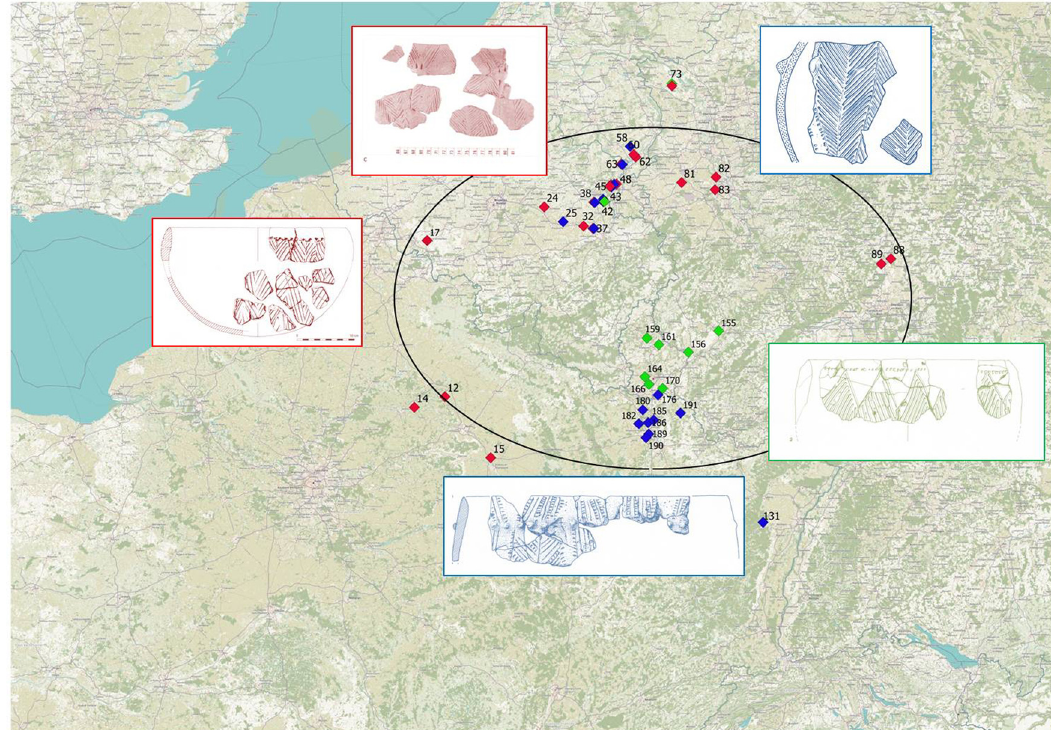
Figure 4: Distribution area of di ff erent technology groups showing stroke decoration pattern. Bone - tempered examples ( red ) from Aubechies ( left ) and Rosmeer ( top center ) , organic - tempered ones ( green ) from Weiler - la - Tour Holzdreisch ( bottom right ) , and mineral - tempered ones ( blue ) from Elsloo ( top right ) , and Ay - sur - Moselle ( bottom center ) . ( Drawing: Author with fi gures from Blouet et al., 2013, p. 164, Figure 67.1; Constantin & Demarez, 1981, p. 213, Figure 2.1; Gomart, 2014, p. 188, Figure 63c; Hauzeur, 2006, p. 646, pl. 192b2; Jadin, 1996, p. 108, Figure 5.2; Modderman, 1981, p. 142, Figure 1.8 )